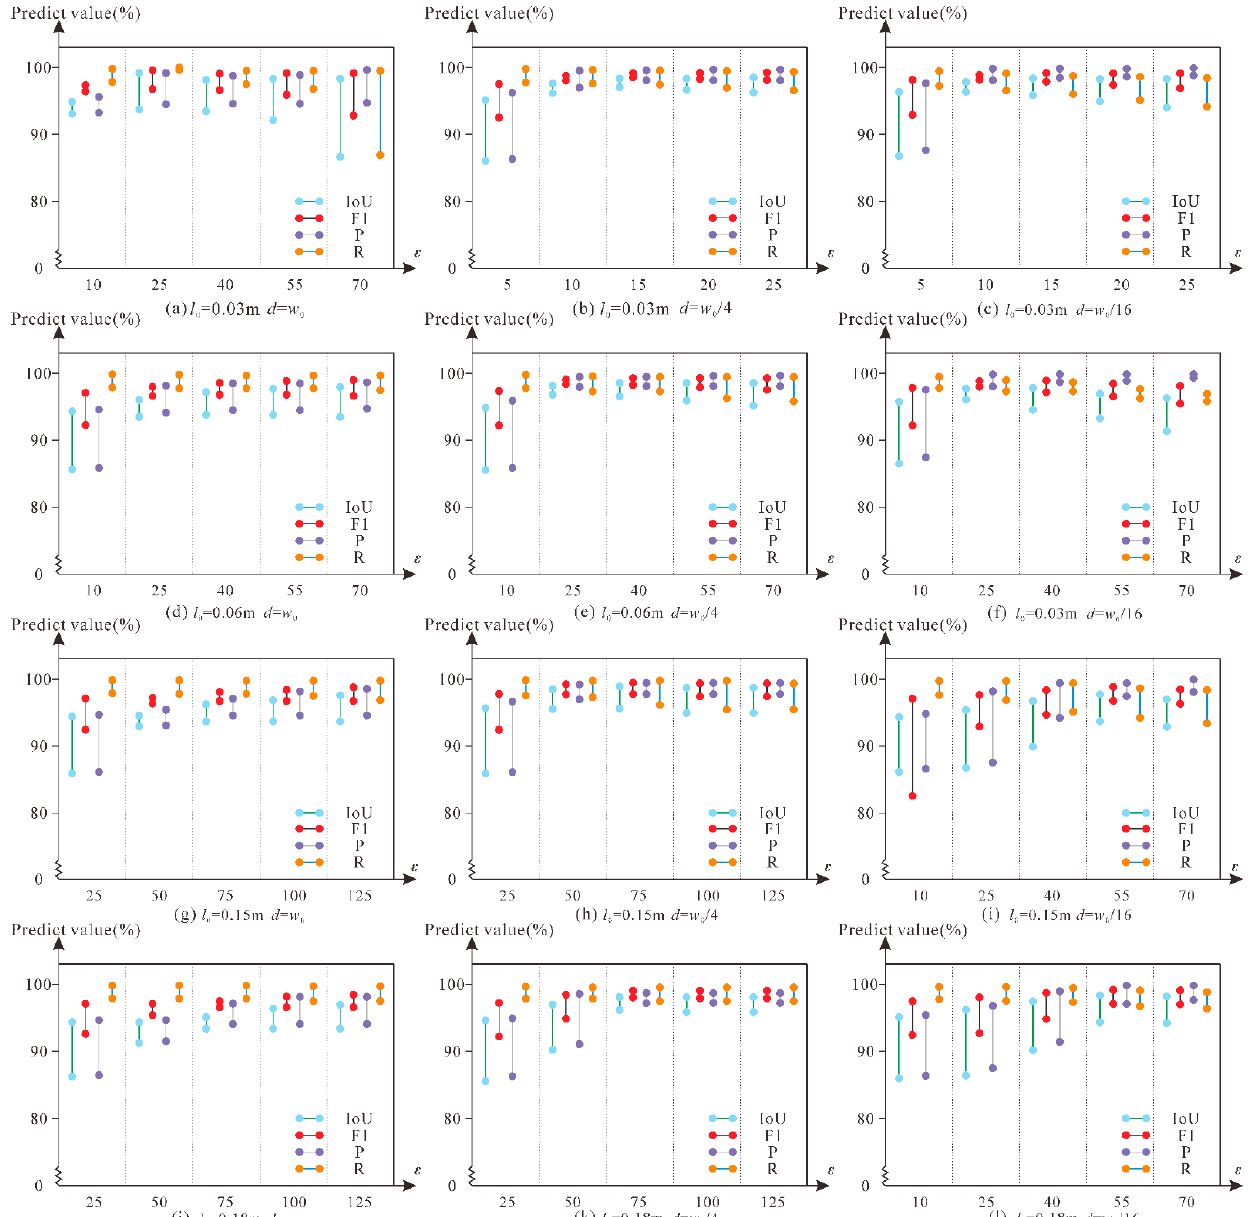
Figure 17. The relationship between voxel size and voxel filter threshold.